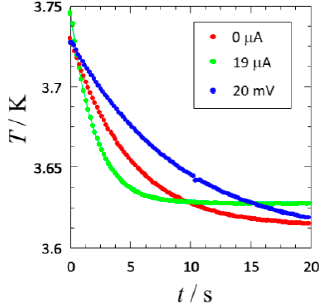
Figure 4. Typical thermal relaxation curves obtained in the present set up. The red circles show the standard case without current and voltage. The green circles denote the relaxation curve for the constant current of I = 19 μ A and the blue ones show the curve for constant voltage with V = 20 mV.